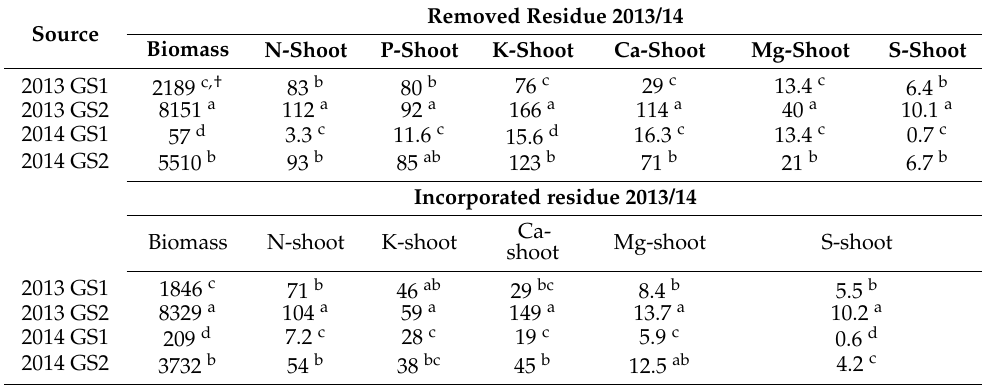
Table A4. Biomass accumulation and biomass N, P, K, Ca, Mg, and S accumulation in 2013 and 2014 as a function of growth stages and